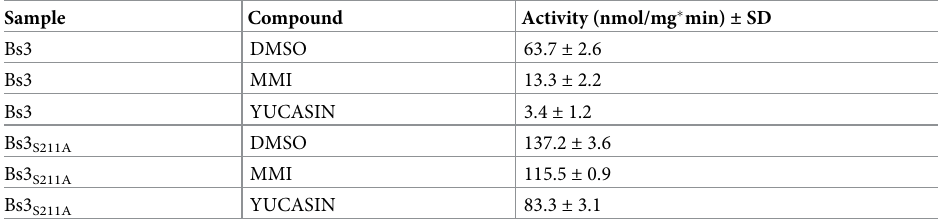
Table 1. Yucasin and methimazole (MMI) decrease NADPH oxidase activity of Bs3 and Bs3 S211A